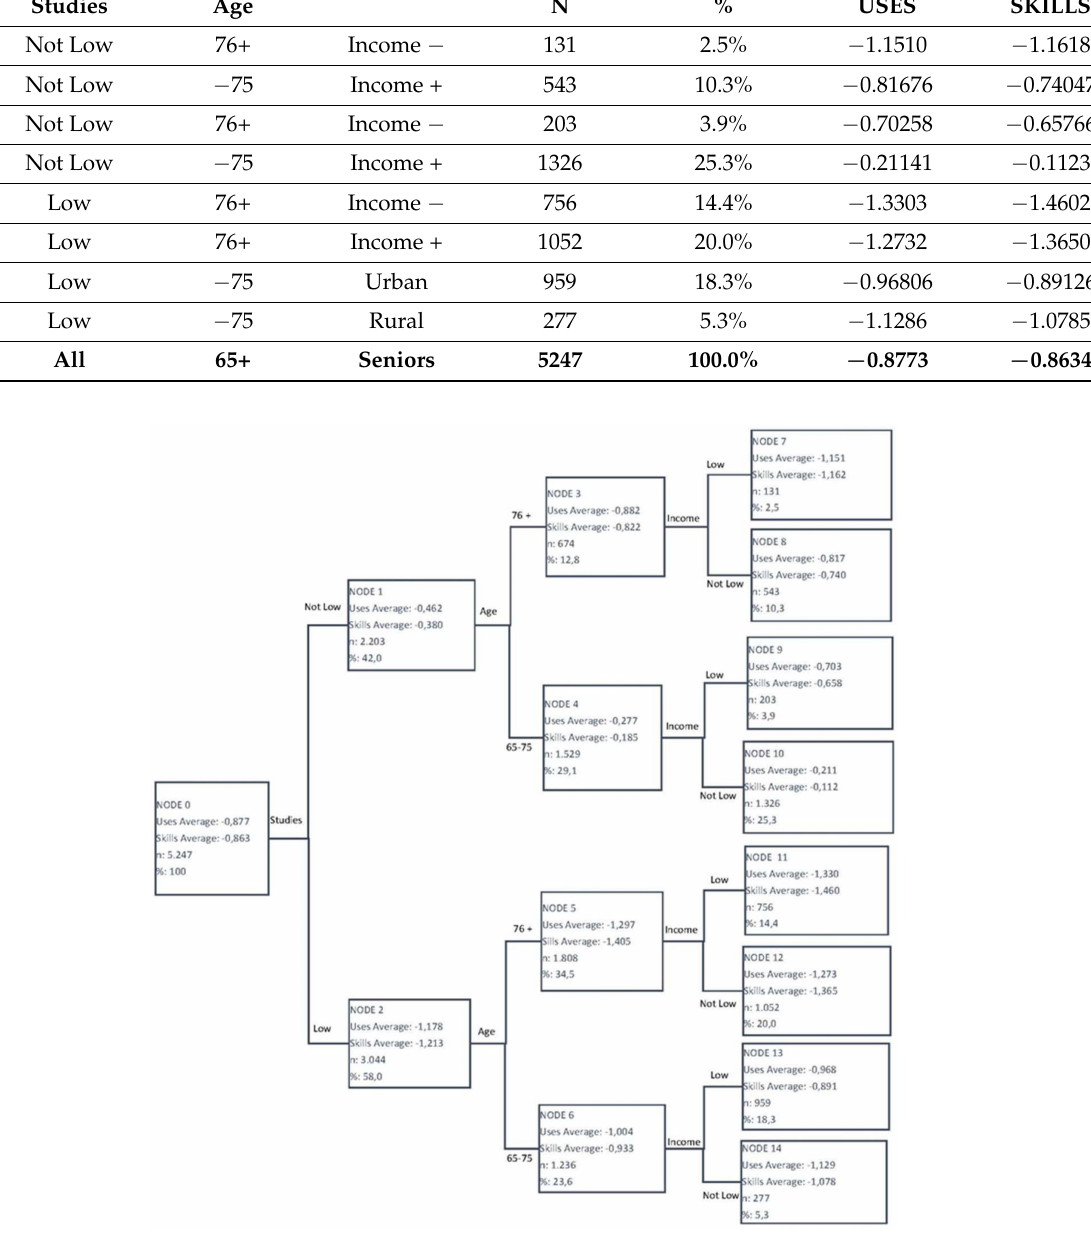
Figure 7. Segmentation